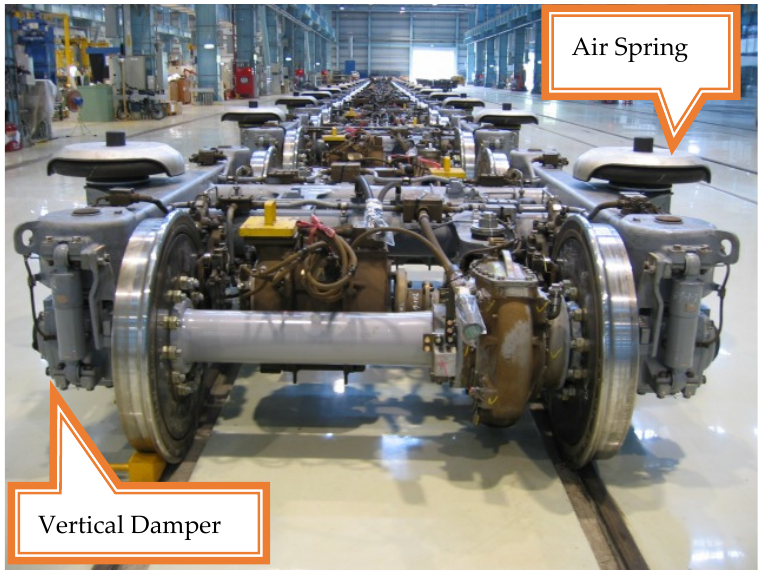
Figure 1. Positions of air spring and vertical damper systems.